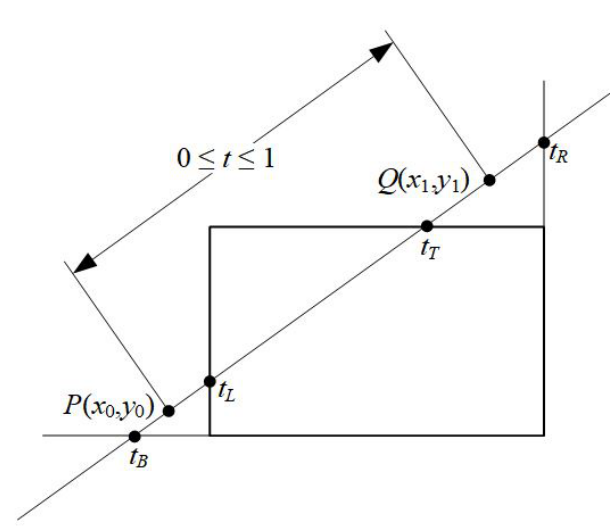
Figure 8. Defining the line for clipping with the Liang–Barsky